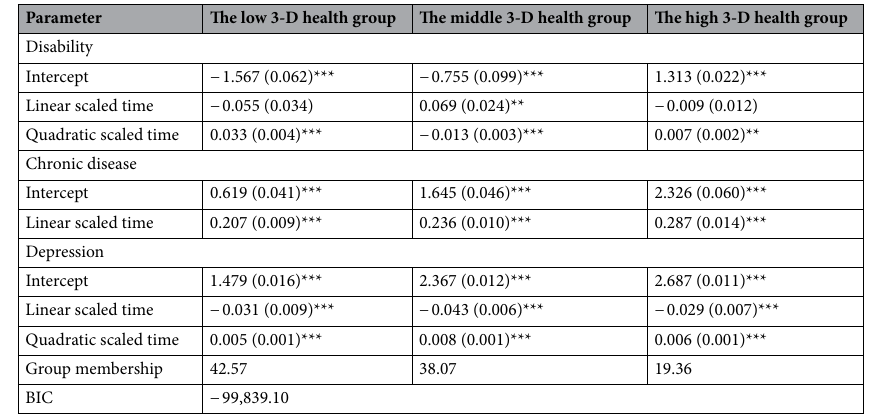
Table 1. Maximum likelihood estimates of disability, disease and depression from the best base model. Standard errors are in parentheses. * p < 0.05; ** p < 0.01; *** p < 0.001.